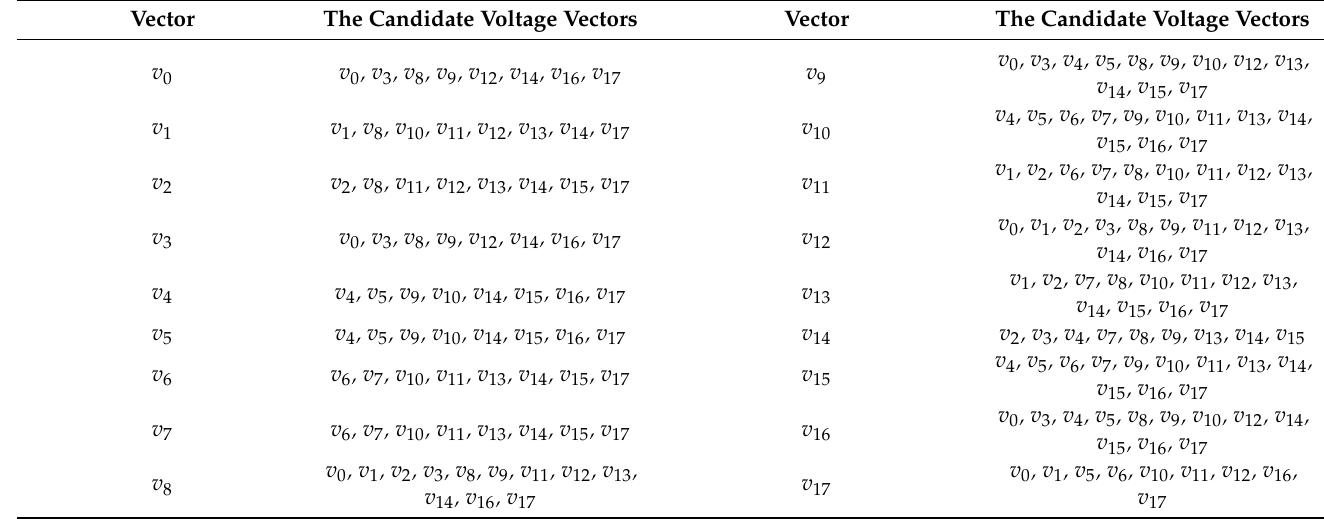
Table 4. The candidate vector pre-selection strategy based on the vector applied at time k. Vector The Candidate Voltage Vectors Vector The Candidate Voltage Vectors